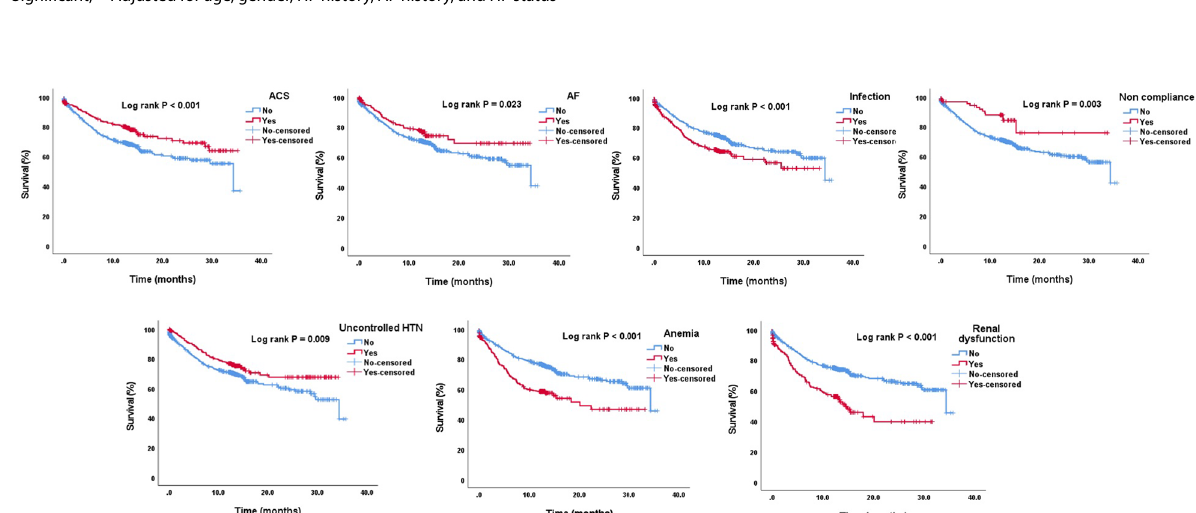
Acute coronary syndrome; AF =